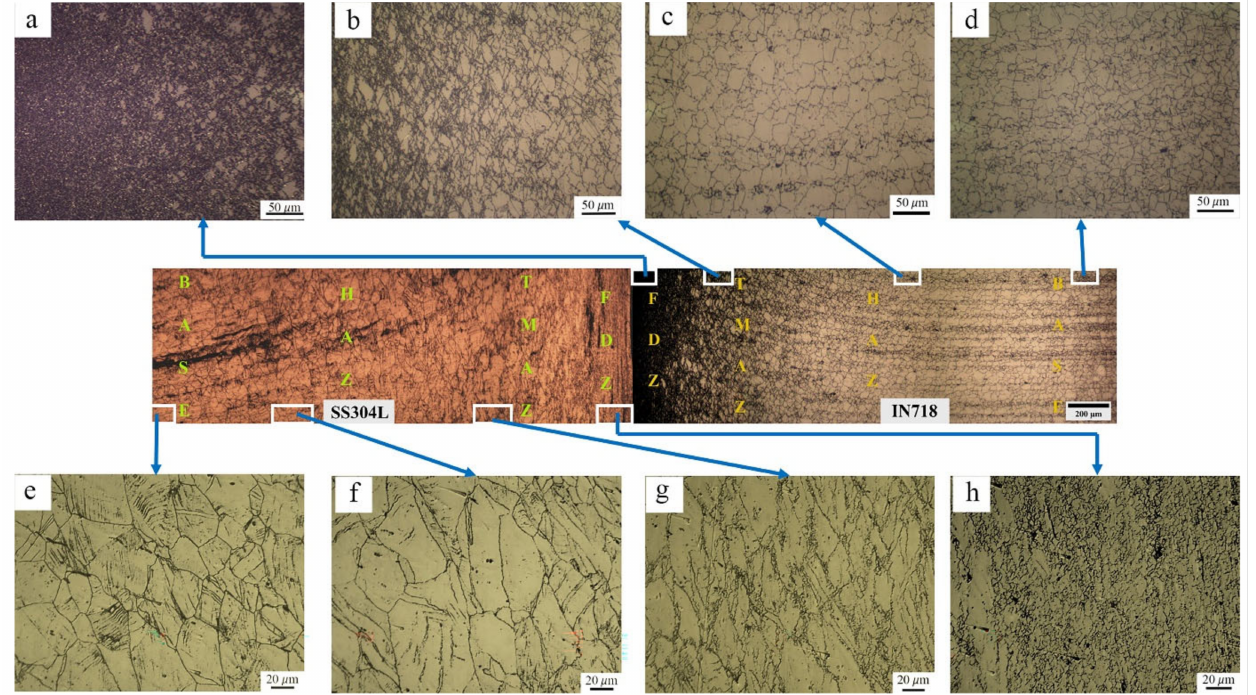
Figure 8. The optical microstructure of the SS304L/IN718 rotary friction welds in the as-welded, solution-treated condition (SS304L/IN718 ST). IN718 side: ( a ) FDZ ( b ) TMAZ ( c ) HAZ ( d ) base metal; SS304L side: ( e ) base metal ( f ) HAZ ( g ) TMAZ ( h )